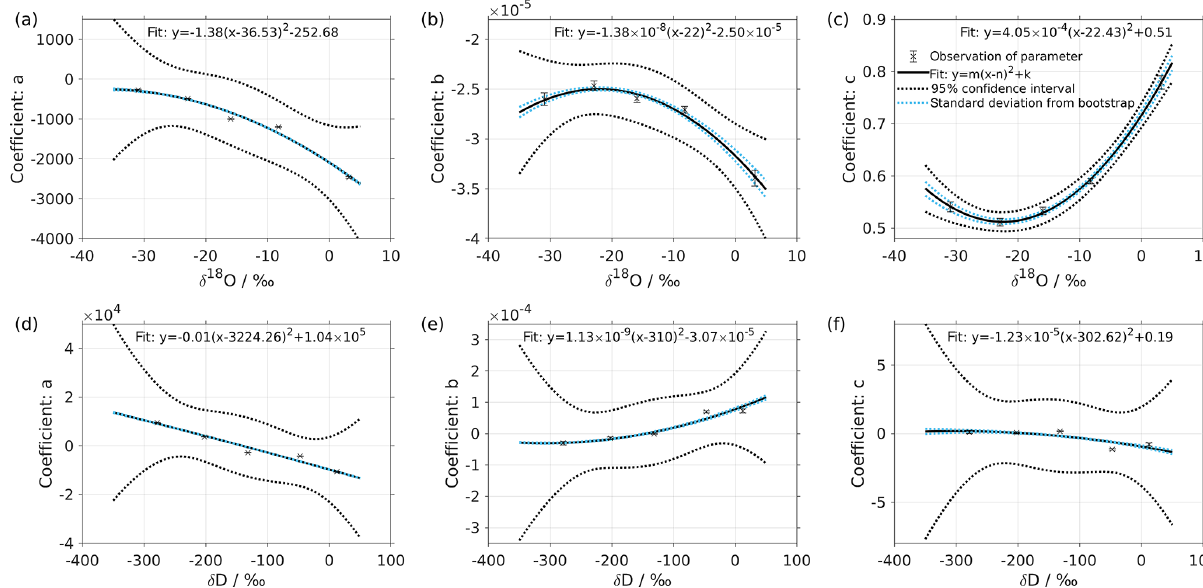
Figure 2. Dependency of fitting coefficients a , b , and c on δ 18 O (a–c) and on δ D (d–f) . The coefficients a , b , and c are from the fits for the five standard waters in Fig. 1. The solid line is the quadratic fit, with f j (y) = m j (y − n j ) 2 + k j . The black dotted line shows the 95% confidence interval. The blue dotted line shows the standard deviation estimated from a bootstrapping method. Table 4. Fitting coefficients for the mixing ratio dependency behaviour of the five standard waters measured with HIDS2254. Coefficients + b δ · x + c δ . The reported uncertainty is 1 standard deviation. The a , b , and c are calculated with respect to the fitting function f δ (x) = a δ x fitting lines are shown in Fig.